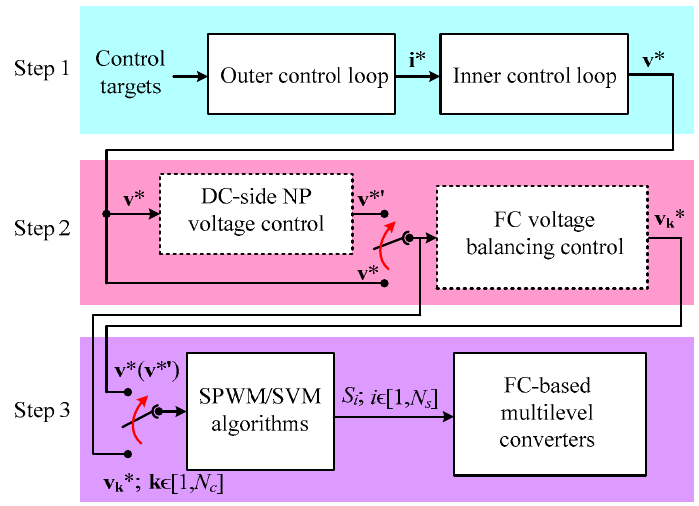
Figure 23. General operation and control structure of the HMCs.